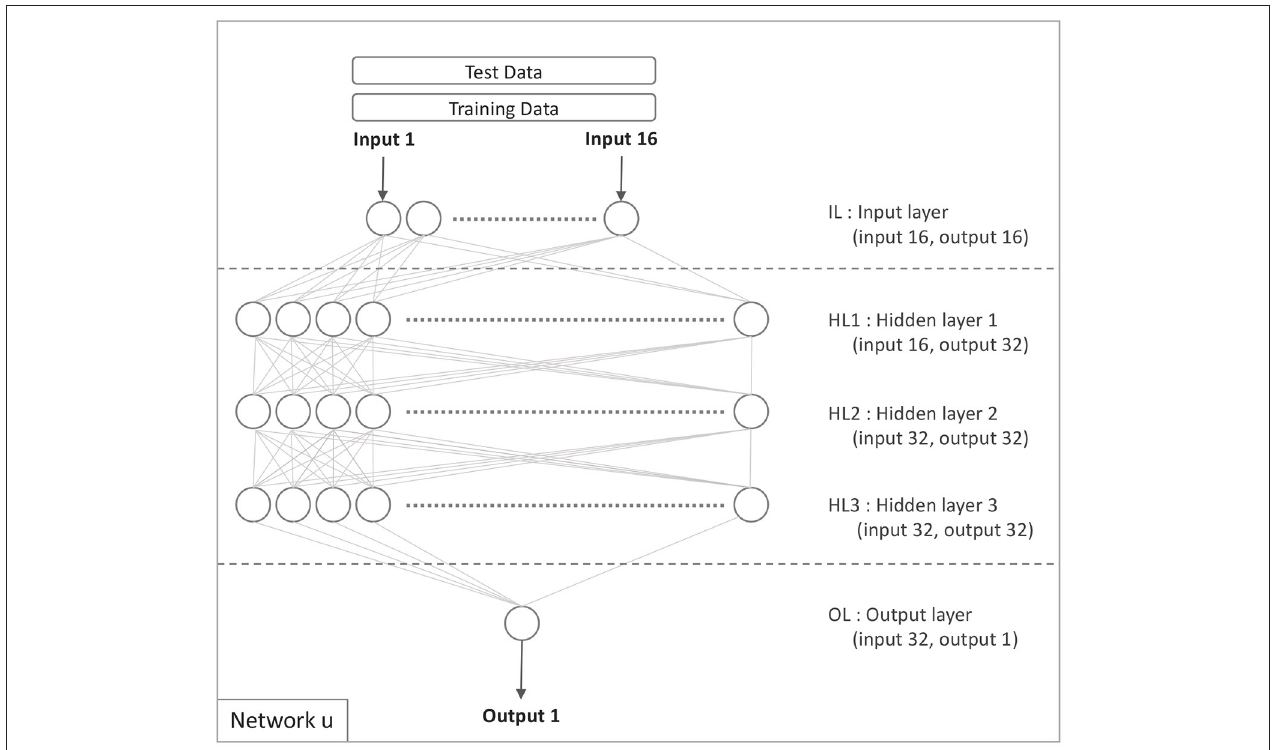
FIGURE 1 | Network u: the base